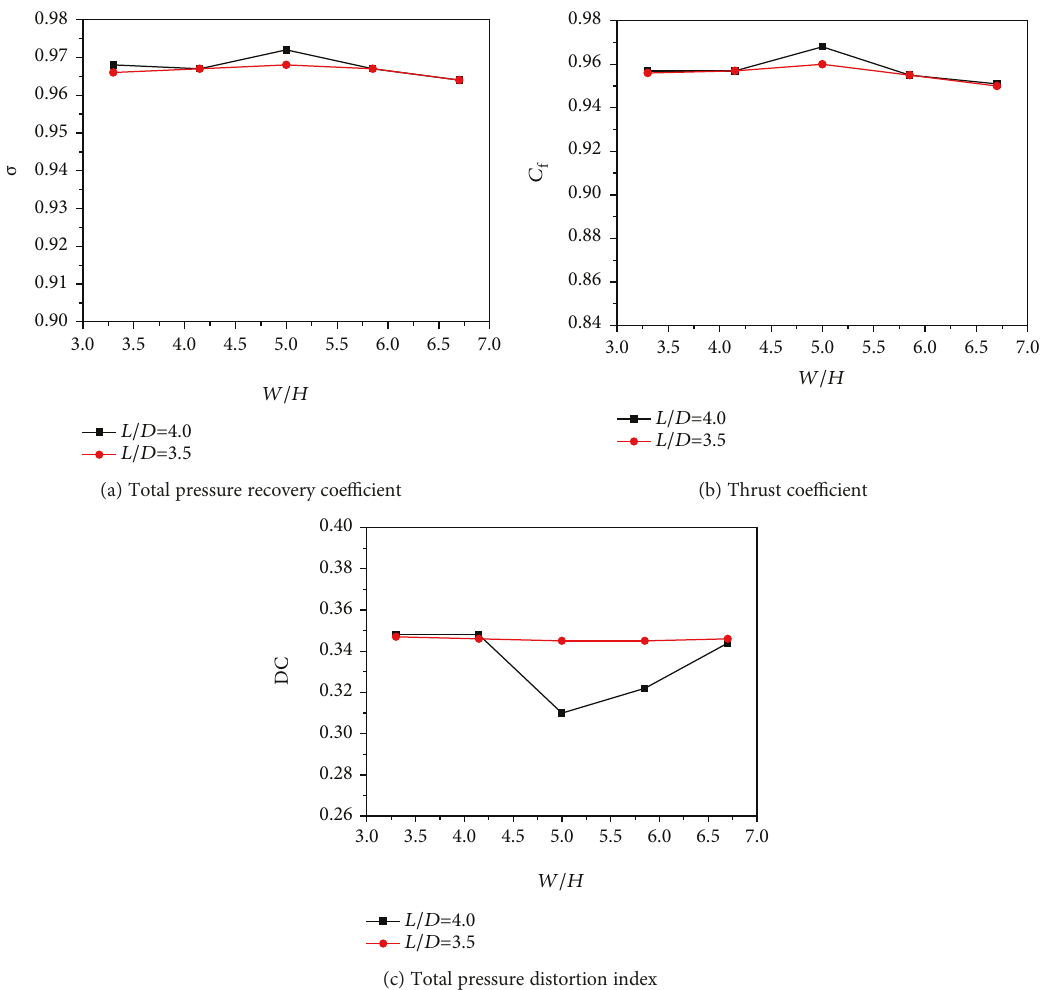
Figure 17: Comparison of performances of nozzles with di ff erent W / H ( S / D = 0